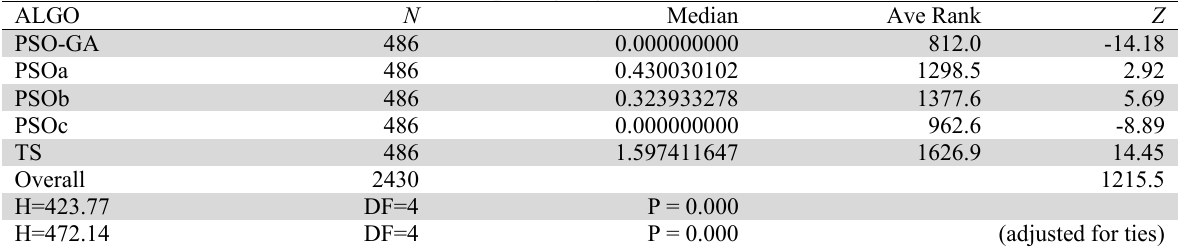
Kruskal-Wallis Test on RPD values of competing algorithms